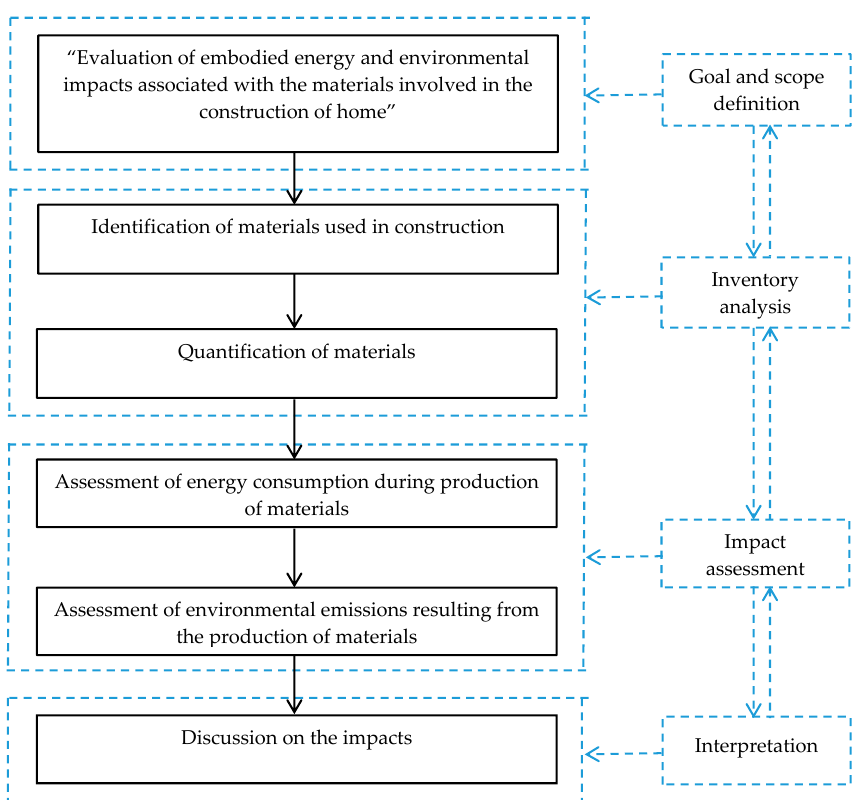
Figure 2. Methodology of the life cycle assessment (LCA) study.